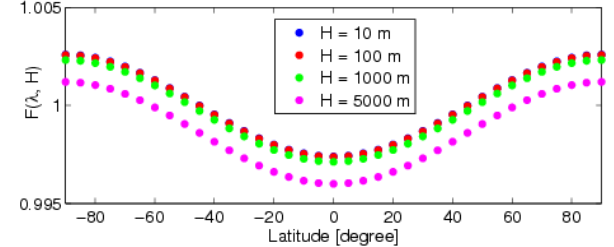
Figure 6. Values of f (λ , H) calculated from different latitudes and from four different site heights.